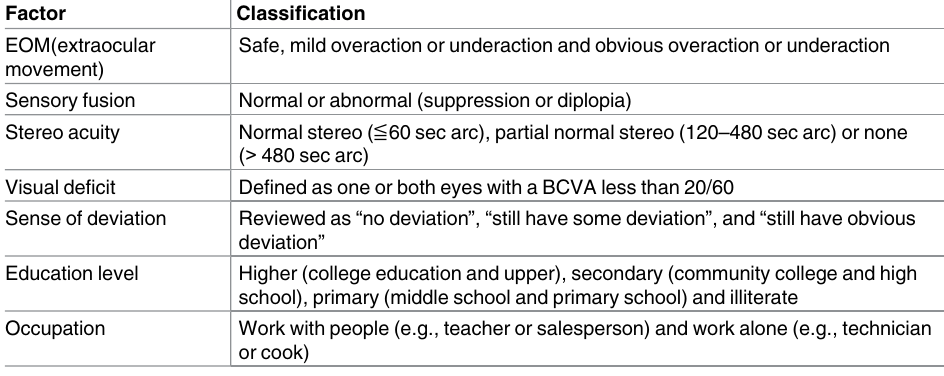
Table 1. Classification of associated